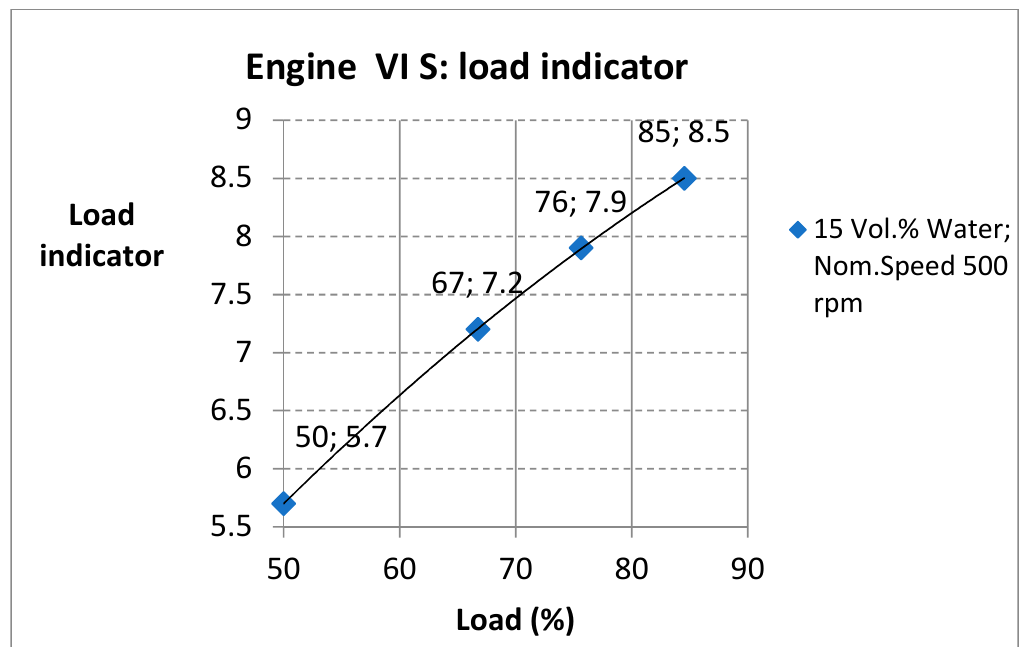
Figure 14. Evolution of specific fuel consumption with power at a constant rotation speed of 500 rpm.